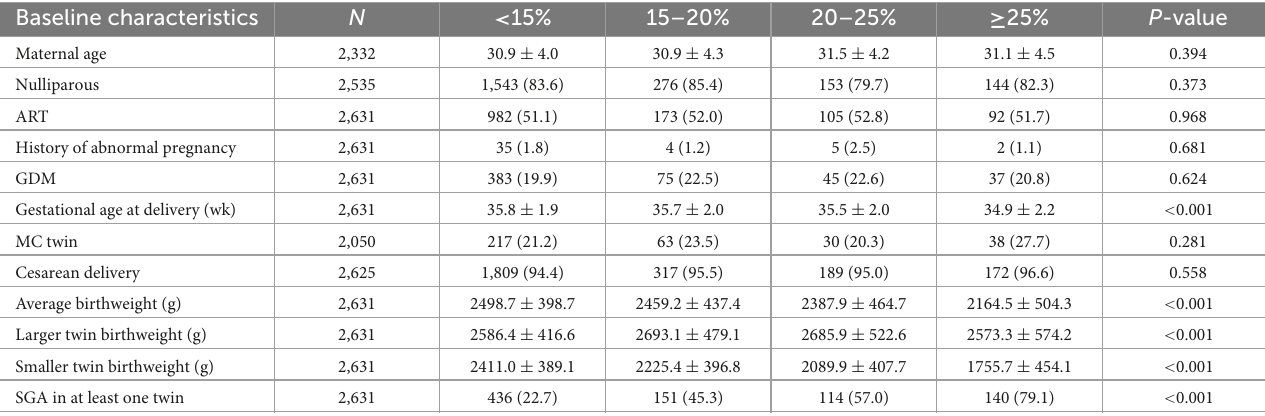
TABLE 1 Baseline characteristics of different degrees of intertwin BWD.